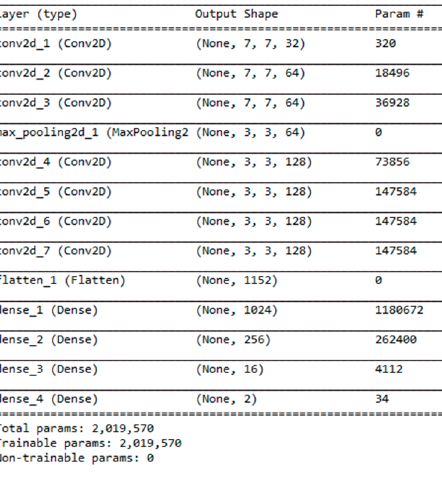
Figure 5. CNN model architecture.